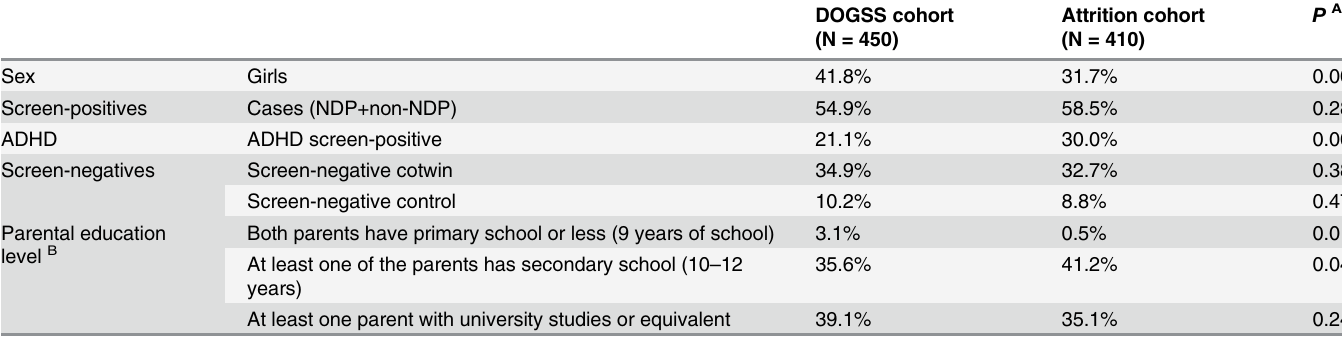
Table 1. Descriptive statistics. Comparison of frequencies in the DOGSS cohort and the attrition cohort.